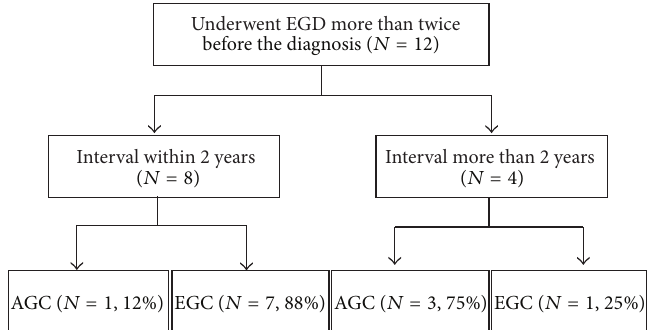
Figure 4: Proportion of early gastric cancer and advanced gastric cancer according to screening interval for gastric cancer. EGD: esophagogastroduodenoscopy; EGC: early gastric cancer; AGC: advanced gastric